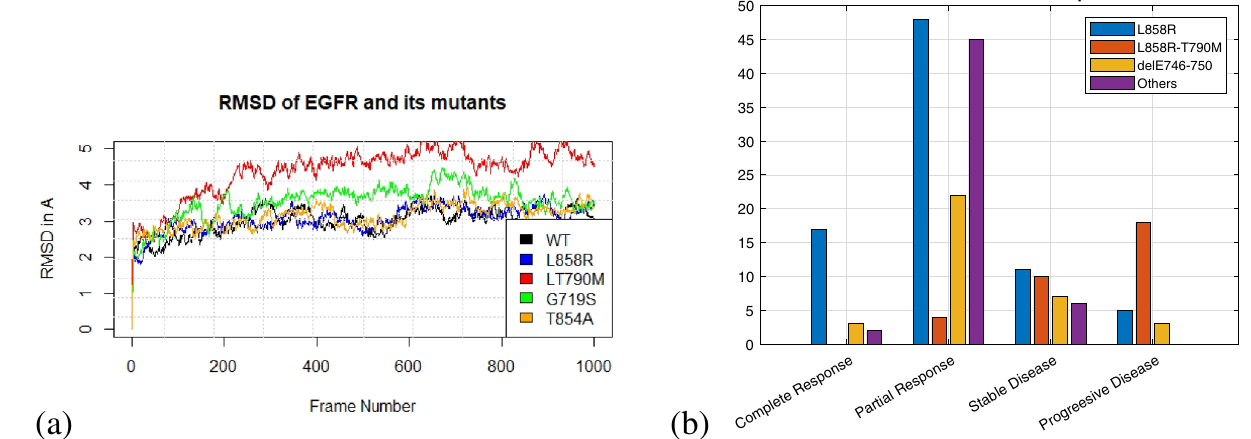
Figure 3. ( a ) MD trajectories of EGFR and some mutants showing RMSD from the reference structure. As the values are below 5, the structures are reliable for further analysis. ( b ) Distribution of disease response classifications for 201 patients by the three most common mutations (L858R, L858R-T790M, del E746-750), and the others.